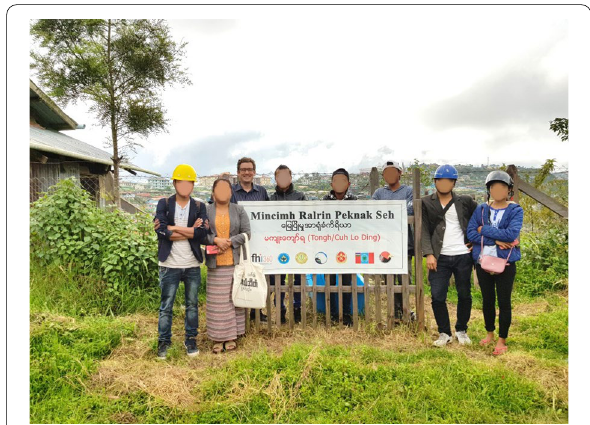
Fig. 9 CCERR with LRV and FHI 360 author publicising the landslide monitoring project via local media